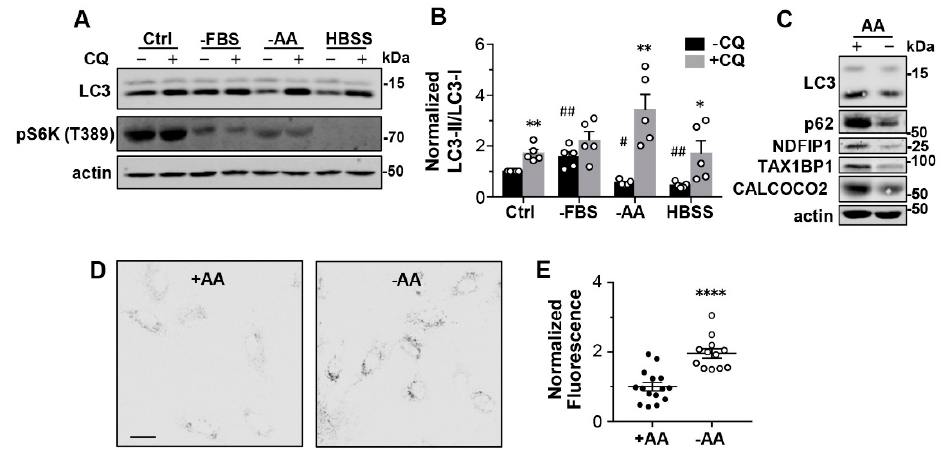
Figure 1. Amino acid starvation accelerates lysosomal degradation. ( A ) Representative Western blot analysis of LC3, phospho-S6K (T389) (pS6K), and actin of MEF cells cultured in normal medium (Ctrl) or subject to 1-h serum starvation ( − FBS), amino acid starvation ( − AA), or complete starvation (HBSS) in the absence ( − ) or presence (+) of chloroquine (CQ, 100 µM). ( B ) Statistics of LC3-II/LC3-I ratios normalized to that of untreated Ctrl for conditions shown in ( A ) from n = 5 experiments. * p < 0.05, ** p < 0.01 vs. corresponding +CQ by Grouped analyses—multiple t tests; # p < 0.01, ## p < 0.01 vs. Ctrl − CQ, by one-way ANOVA with Dunnett’s multiple comparisons test. ( C ) Western blot analysis of LC3, p62, NDFIP1, TAX1BP1, CALCOCO2, and actin of primary human skin fibroblasts, BJ cells, cultured in normal medium or subject to 1-h amino acid starvation. ( D ) Representative images of DQ-BSA loaded MEF cells cultured in normal medium (+AA) or subject to 1-h amino acid starvation ( − AA). Scale bar, 20 µ m. ( E ) Statistics of fluorescence intensities of individual cells normalized to the mean of the +AA controls. **** p < 0.0001 by t